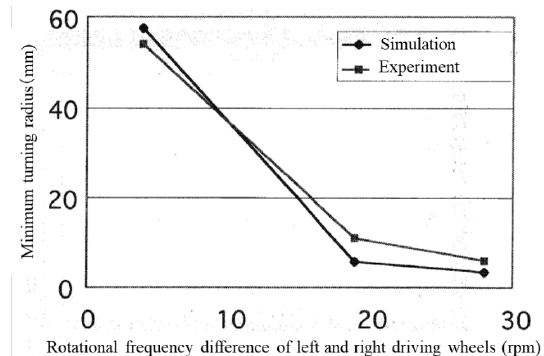
Figure 18. Relationship between the minimum turning radius and the difference of the rotational frequencies of left and right driving wheels of experiment and simulation. The circle marks show the simulation results and square marks show the experimental results.